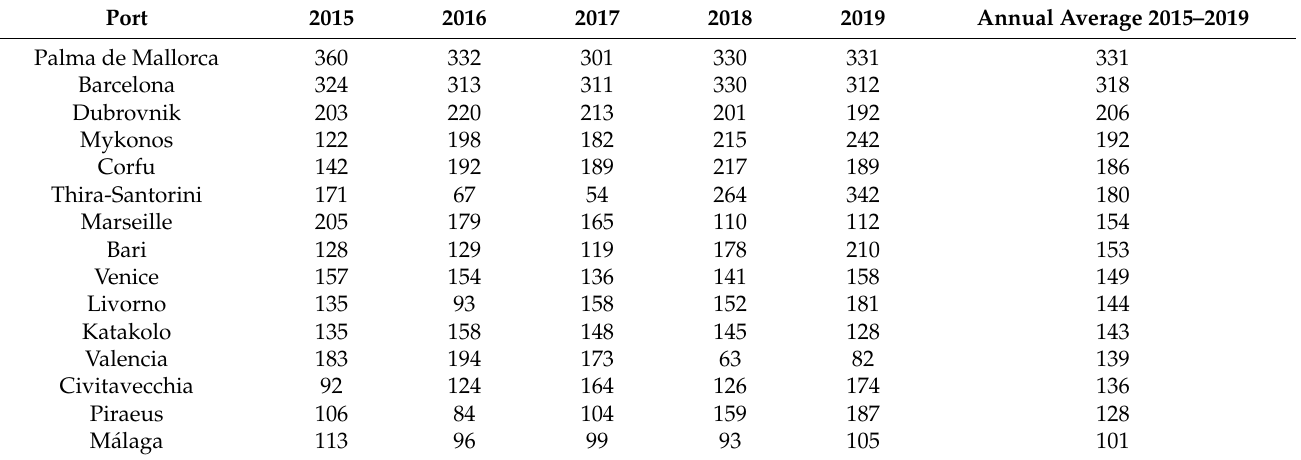
Table 4. Top 15 ports in terms of generated flow and its evolution from 2015 to 2019 in the contempo- rary cruise port network in Southern